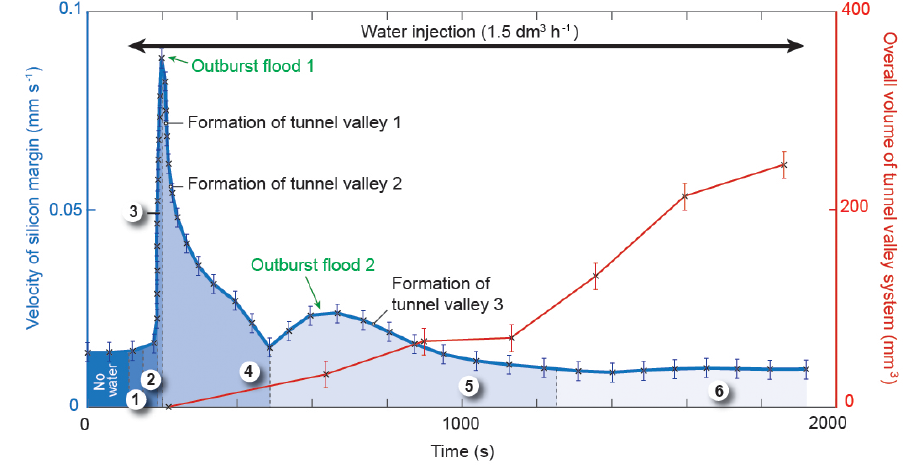
Figure 5. Progressive expansion of overall volume of tunnel valley system vs. velocity of silicon margin through the experiment. The circled numbers correspond to the six stages of the proposed ice stream life